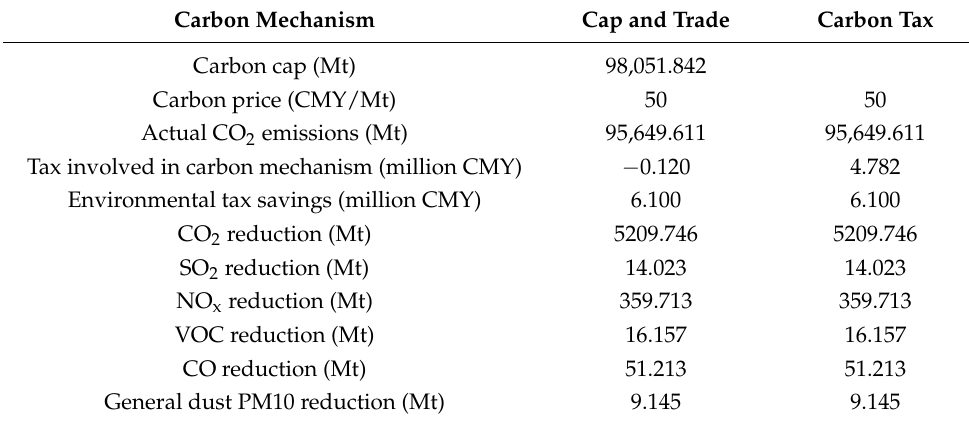
Table 3. Comparison of the impact of subsidy rates on environmental benefits to all parties under the two carbon